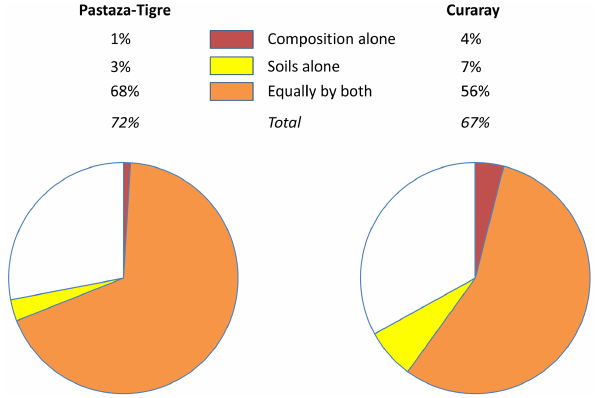
Figure 3. Contributions of soil fertility and plant species compo- sition to PV–NPV values. Pie charts representing the percentage of variation in PV–NPV values explained by NMDS values alone (red), LSC values (yellow), or equally by both (orange), for the Pastaza–Tigre and Curaray study areas; correlation coefficients are provided in Table